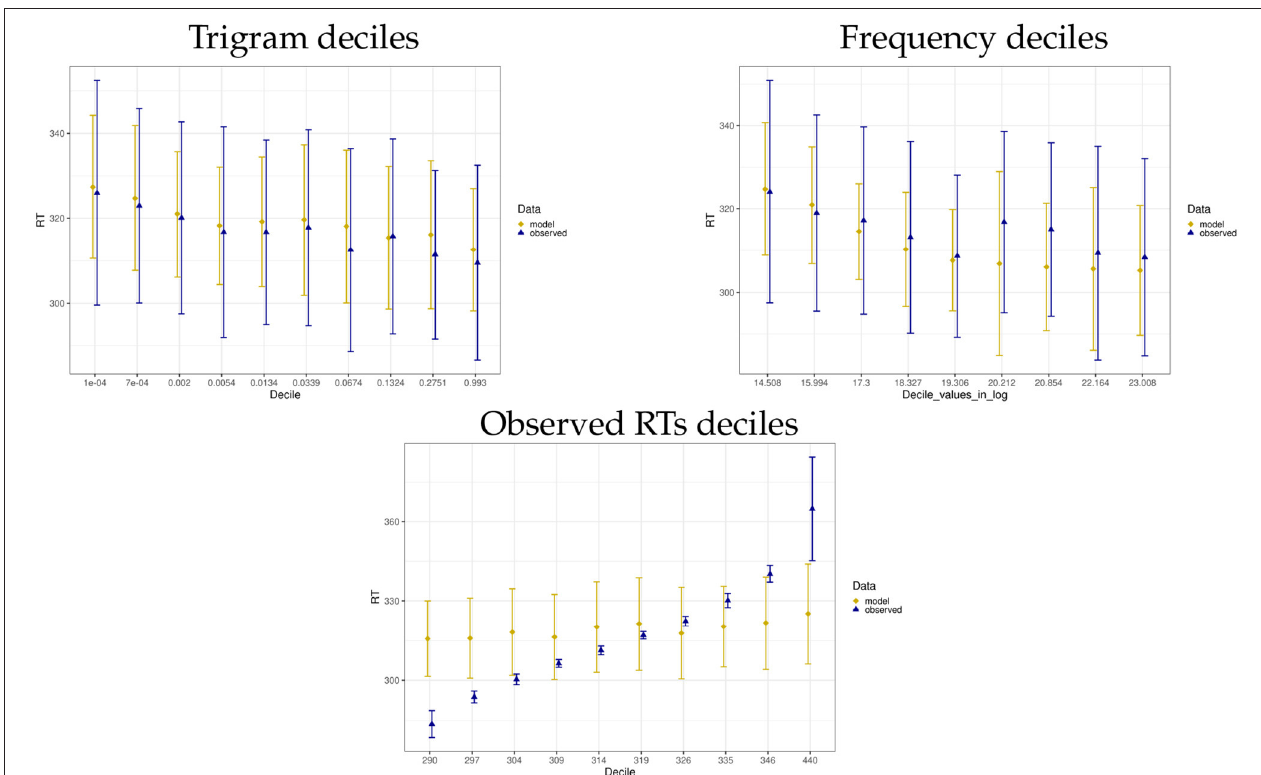
FIGURE 5 | Mean and standard deviation summaries of model and data split per trigram, frequency and observed mean RT deciles. The x-axis label shows the upper cut-off point per decile (given in log in case of Frequency). In case of Frequency, only 9 deciles are present. This is because a single word ( the ) spans the top two